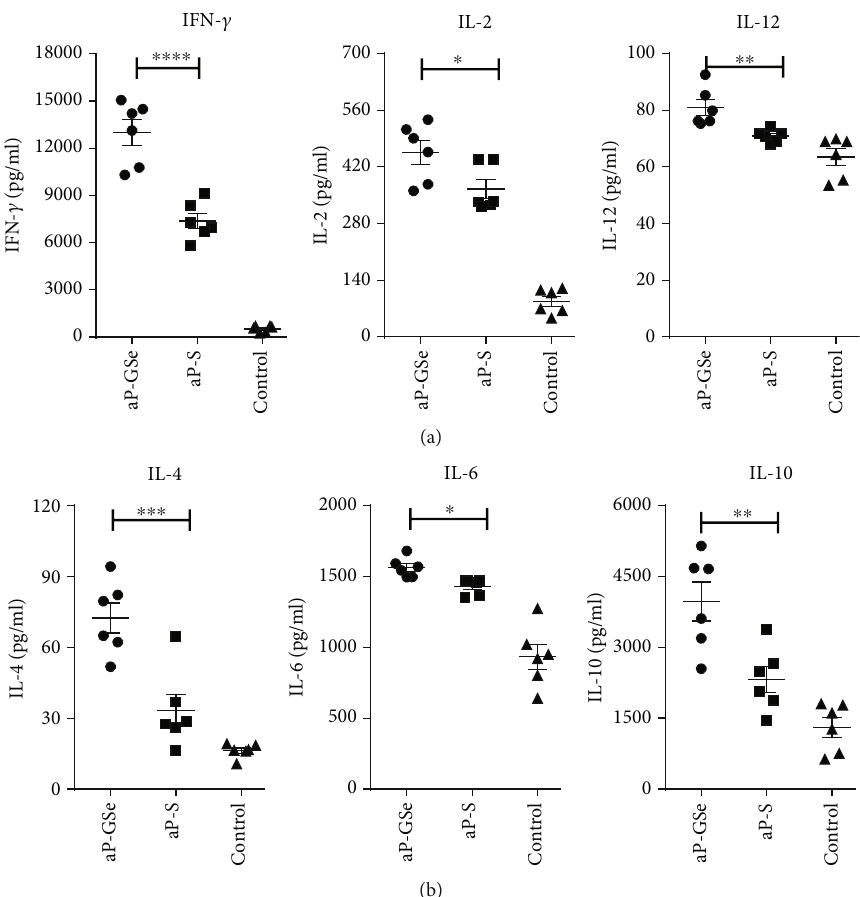
Figure 5: Production of IFN- γ , IL-4, IL-2, IL-6, IL-12, and IL-10 by splenocytes. Mice ( n = 6 /group) received twice i.m. injection of aP-GSe or aP-S at two weeks apart. Mice injected with saline served as control. Splenocytes were prepared 2 weeks after boost immunization and cultured with PrV antigen for 48h. The supernatants were harvested for analysis of (a) Th1-type cytokines (IFN- γ , IL-2, IL-12) and (b) Th2-type cytokines (IL-4, IL-6, IL-10) by ELISA. Data are expressed as the mean ± SE . ∗ p < 0 : 05 , ∗∗ p < 0 : 01 , ∗∗∗ p < 0 : 001 , ∗∗∗∗ p < 0 : 0001 vs. aP-S group as indicated by one-way ANOVA with the LSD test.